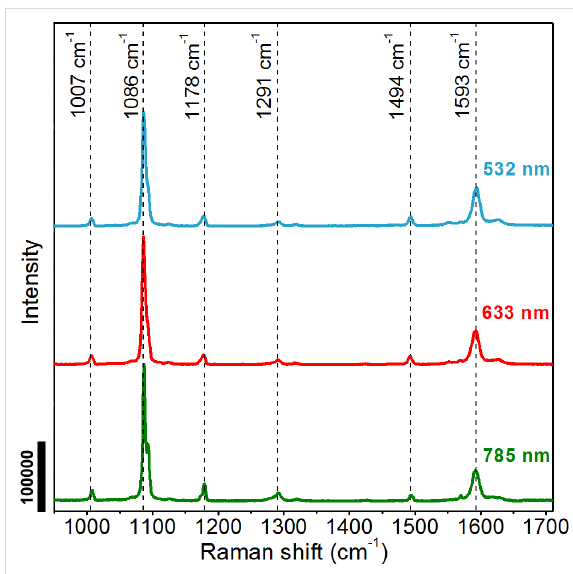
Figure 7: Comparison of the Raman spectra of the bulk pMA re- corded using three excitation wavelengths of 532, 633 and 785 nm.